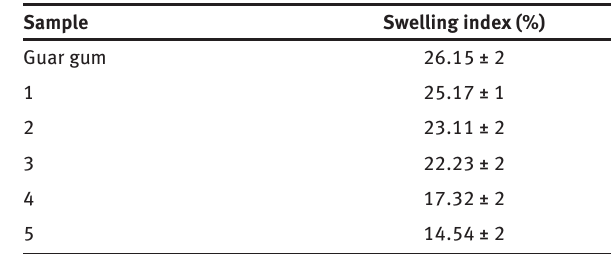
Table 2: Swelling index of modified guar gum